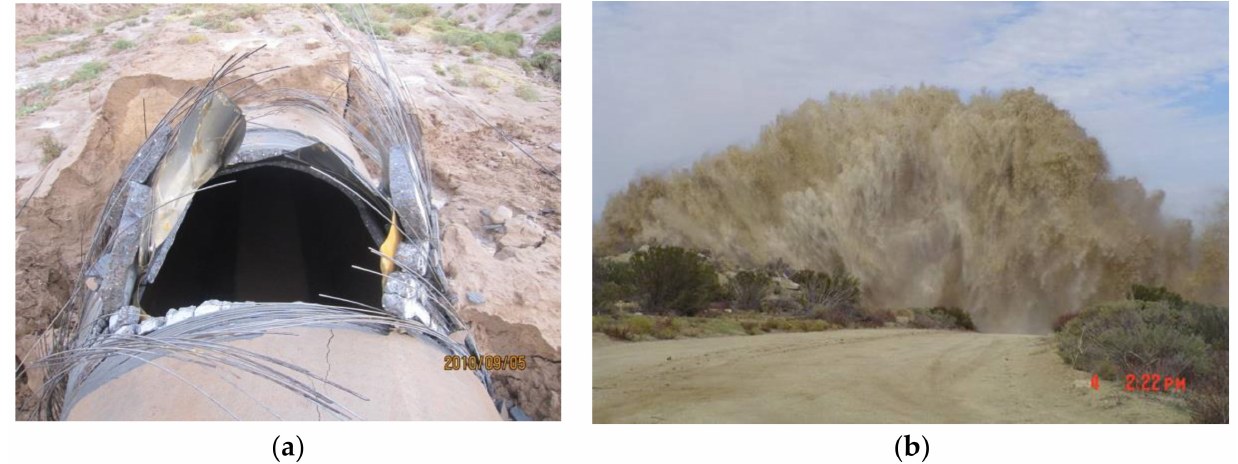
Figure 2. Bursting pipe: ( a ) after the bursting event, ( b ) during the bursting